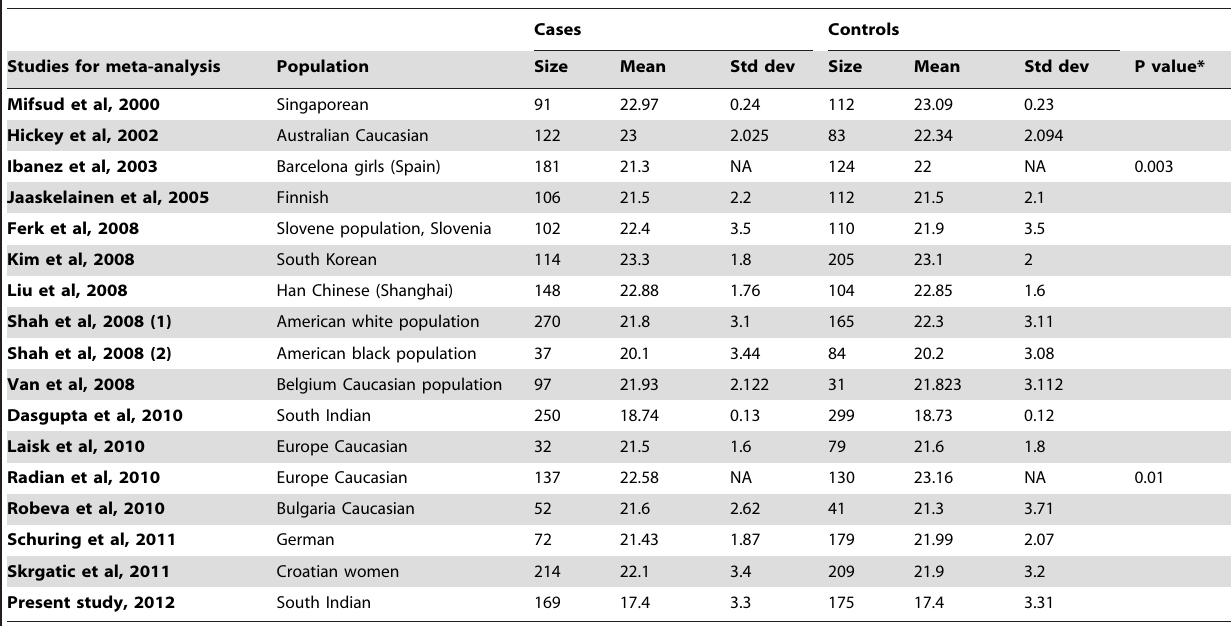
Table 5. Published data extracted for